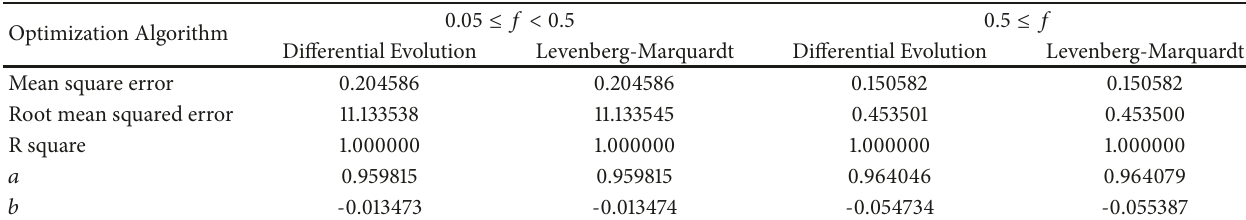
Figure 7: Cumulative probability distribution of 𝛿 . Table 3: Fitting parameters of Market Capitalization of Yearly End